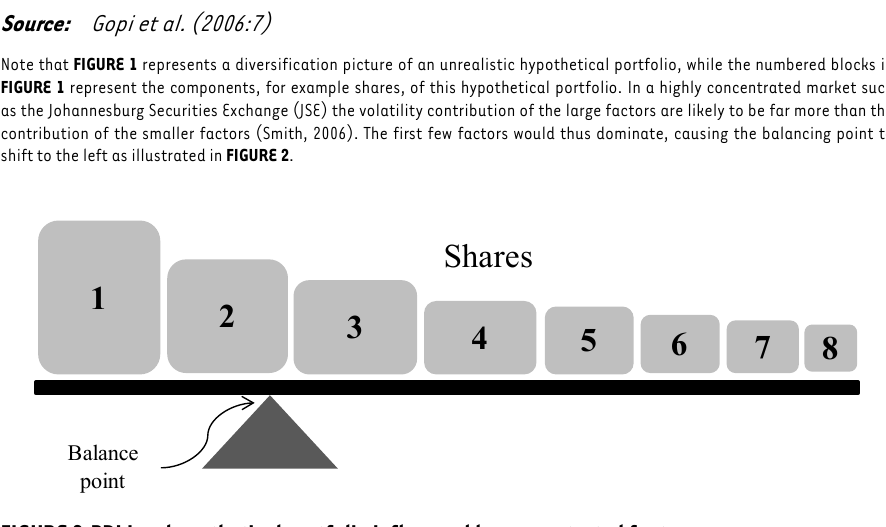
FIGURE 2 PDI in a hypothetical portfolio influenced by concentrated factors Source: Gopi et al.